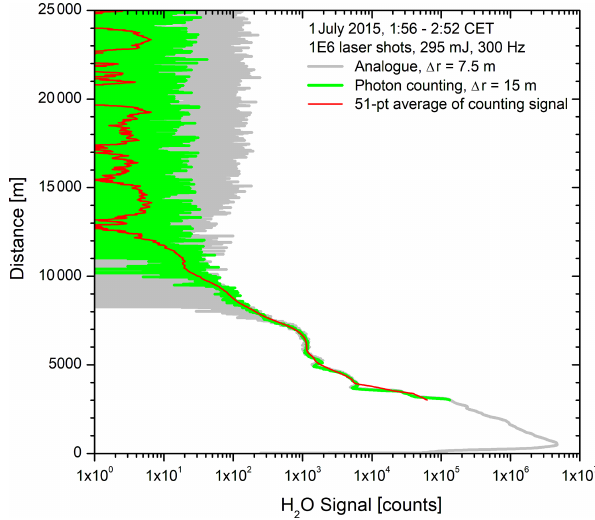
Figure 10. 347nm Raman backscatter signals as a function of the vertical distance above UFS, obtained during the first hours on 1 July 2015. Despite a high noise level of about 12 counts (square root of signal) the averaged signal remains positive up to r = 19.7km. The averaged signal covers 6 decades, the peak signal being roughly 3mV. The average laser pulse energy, 295mJ, was low due to a contaminated cell